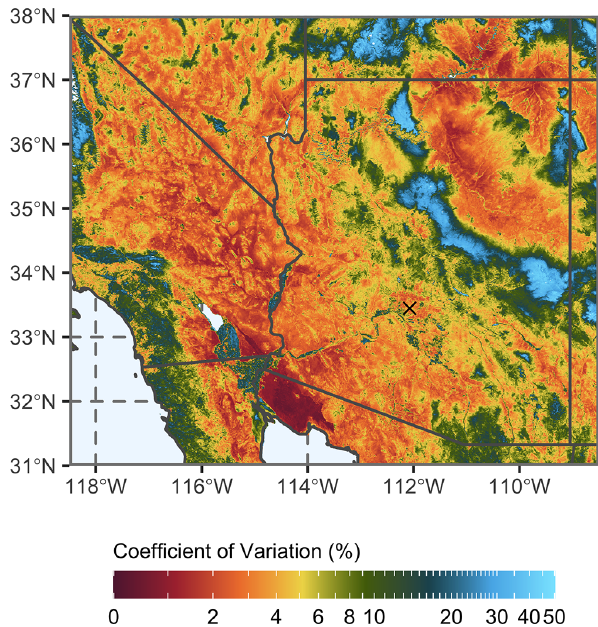
Figure 16. The spatiotemporal variability of u ns ∗ for the 2001– 2021 MODIS record shown as the coefficient of variation of monthly u ns ∗ as a percentage. The black × marks the location of Phoenix, Arizona. Note that the color bar tick marks increase in increments of 5% after the 30%